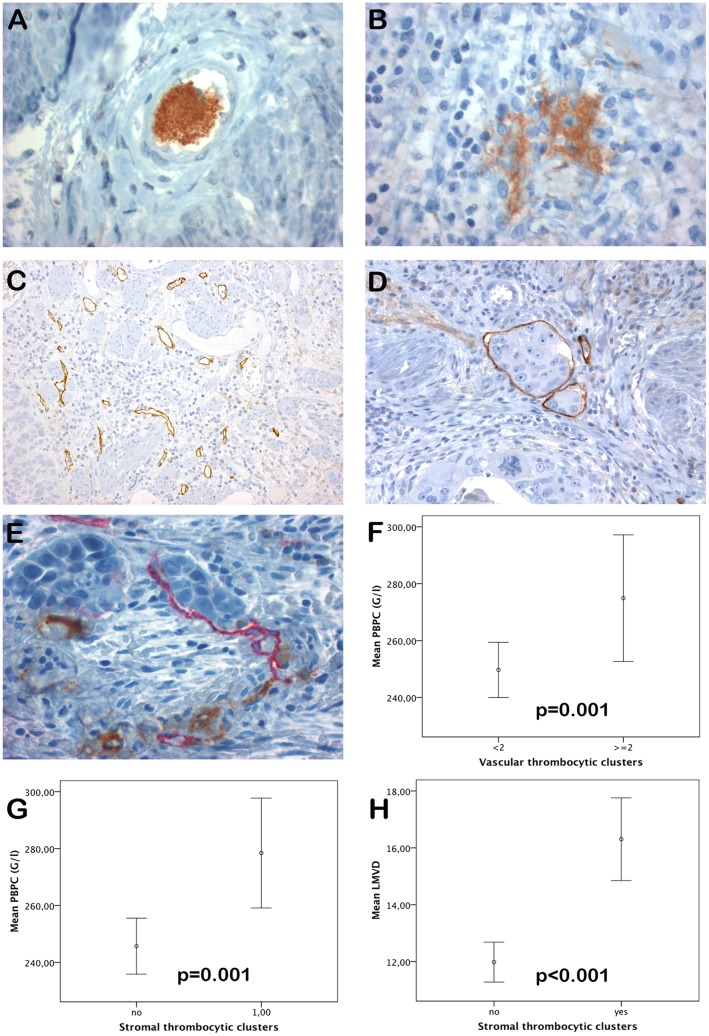
Samples and results of immunohistochemistry.A: Vascular thrombocytic cluster (VTC) in an esophageal cancer specimen (original magnification x400). B: Stromal thrombocytic cluster (STC) in an esophageal cancer specimen assessed by anti – CD61 immunostaining (original magnification x400). C: Esophageal cancer specimen with high lymphatic microvessel density (LMVD) assessed by anti- podoplanin immunostaining (original magnification x200). D: Lymphovascular invasion of tumor cells assessed by anti-podoplanin immunostaining (original magnification x200). E: Double staining for lymphatic vessels using (red, anti-podoplanin) and thrombocytes (brown, anti- CD61) (original magnification x400). F–H: Error bars showing mean values±2× standard error. Peripheral blood platelet counts (PBPC) were significantly higher in samples with VTC (F). PBPC (G) and LMVD (H) were significantly higher in esophageal cancer samples with STC.